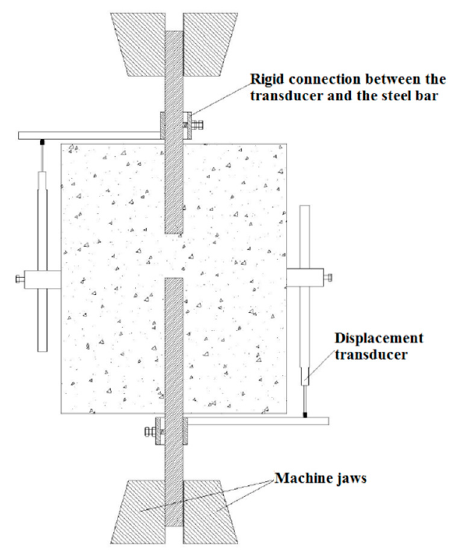
Figure 2. Schematic representation of the test setup.